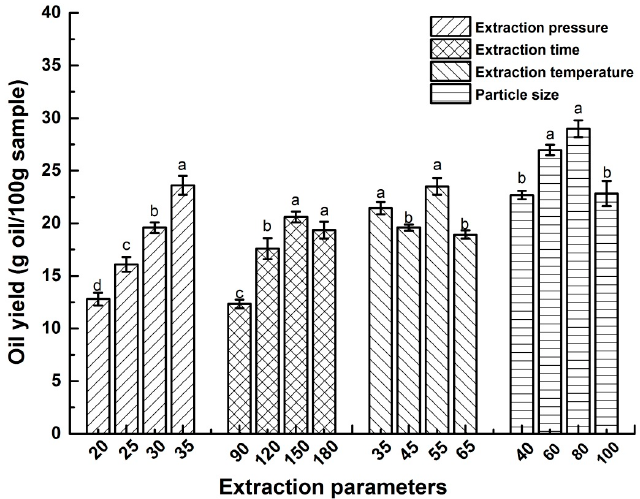
Figure 1. EDS oil yield at different extraction parameters. Values in the bar with different letters (a, b, c, d) are significant difference at p < 0.05.